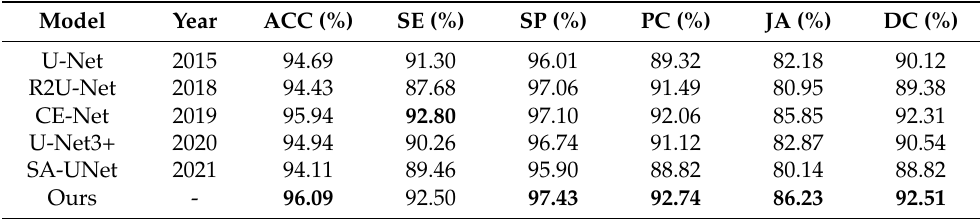
Table 6. Evaluation indicators of each comparative network on ISBI2016.